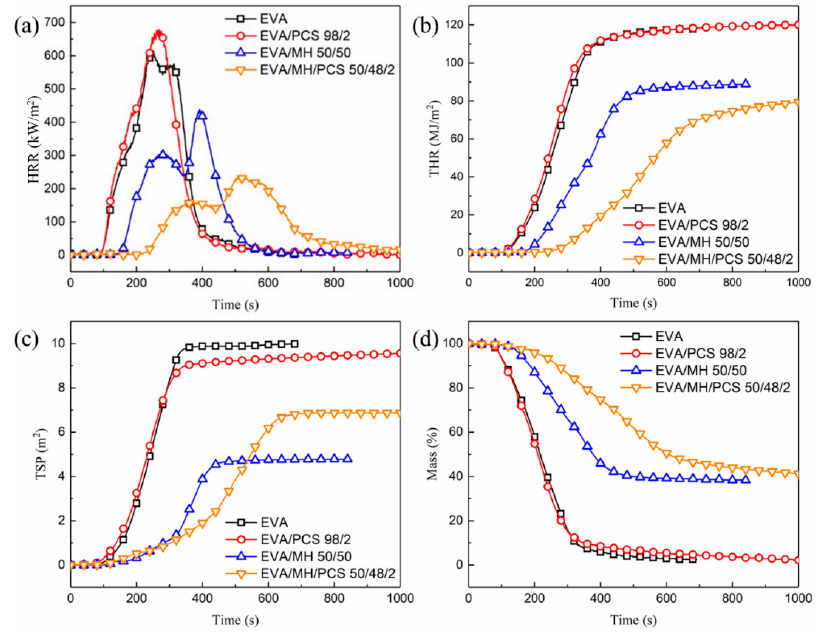
Figure 3. The combustion behaviors of EVA and its composites: ( a ) HRR, ( b ) THR, ( c ) TSP, and ( d ) mass. Table 1. The combustion parameters of EVA and its composites.